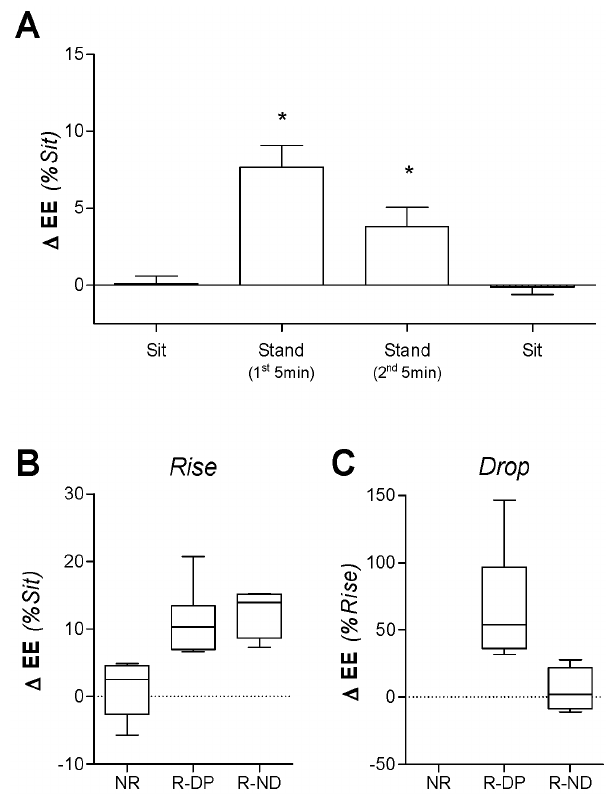
Figure 2. Energy expenditure (EE) during sitting and steady- state (SS) standing. Mean 6 SEM energy expenditure (EE) during sitting and steady-state (SS) standing, expressed as percentage change relative to mean sitting EE (Panel A); *statistically significant from baseline as assessed by repeated-measures ANOVA followed by Dunnett’s multiple comparison tests. In the present study the percentage change from the mean sitting value to the mean of the first 5 min of the SS-standing period is referred to as ‘‘rise’’ from sitting value. The percentage change from the mean of the first 5 min to the mean of the second 5 min of the SS-standing period is referred to as ‘‘drop’’ to sitting value. Box and whisker plot comparing rise (Panel B) and drop (Panel C) for each EE response group. NR=Non-Responders, R-DP=Responder Droppers, R-ND=Responder Non-Droppers.